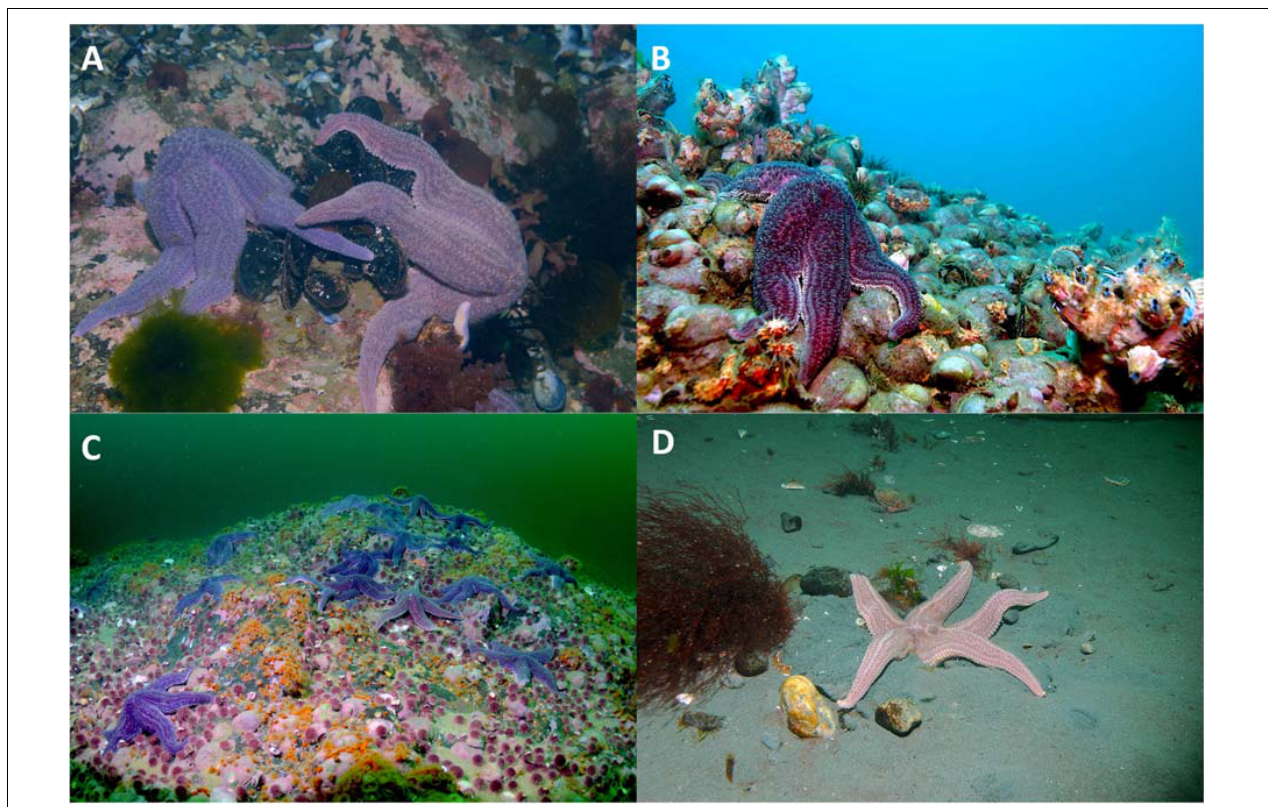
FIGURE 1 | The sea star Cosmasterias lurida on different substrata in southern Chile. (A) Feeding on mussels on a rocky bottom at 7-m depth; (B) feeding on Crepipatella spp. on a rocky bottom at 8-m depth; (C) occurring at high densities on a rocky bottom at 10-m depth; (D) foraging on a sandy bottom at 9-m depth ( A–C – Yerbas Buenas Bay, Seno del Reloncaví; (D) – Faro San Isidro, Magellan Strait, Chile).